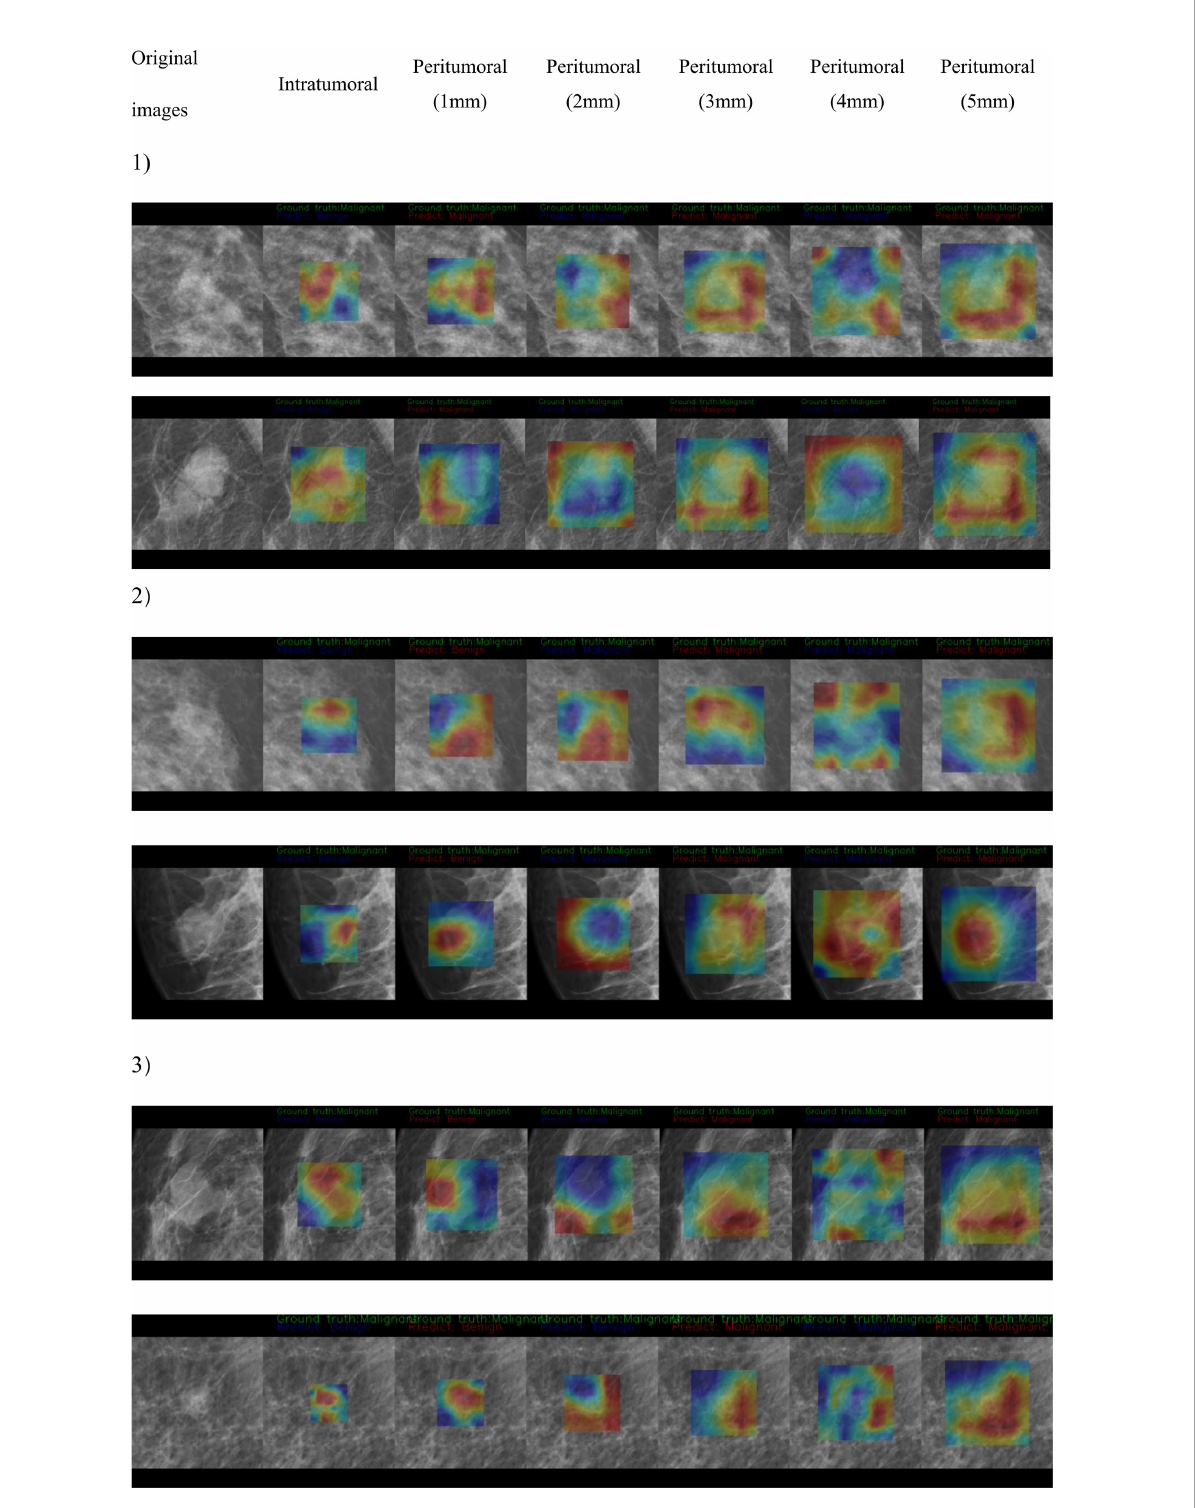
FIGURE 4-2 CAM status of tumoral and peritumoral regions were observed on 6 patients with malignant masses. Tumoral region predictions were wrong. Proximal peritumoral region predictions as follows:1) regions of both 1 mm and 2 mm were correct. 2) regions of 1 mm were wrong, regions of 2 mm were correct. 3) regions of both 1 mm and 2 mm were